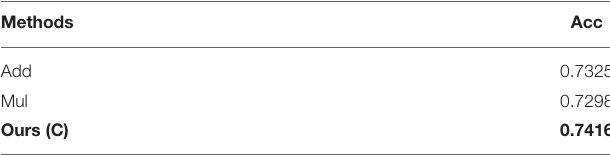
TABLE 6 | Results of ablation experiments for feature fusion strategy on FER2013